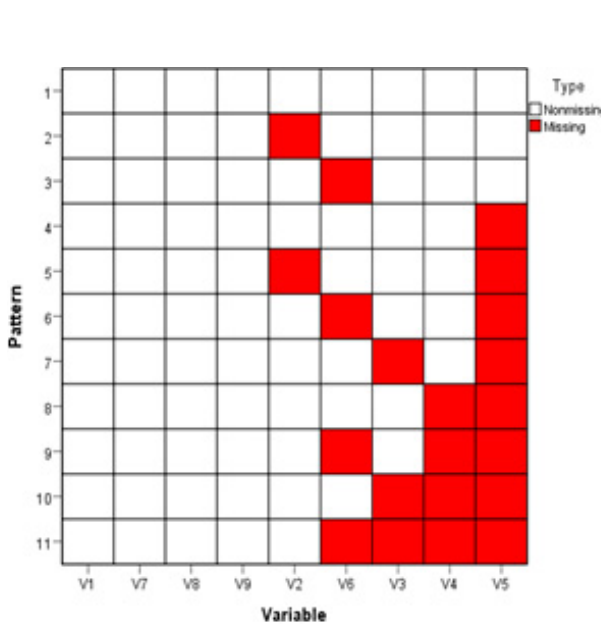
Fig. 3. Pattern of missing values in Pima Indians Diabetes